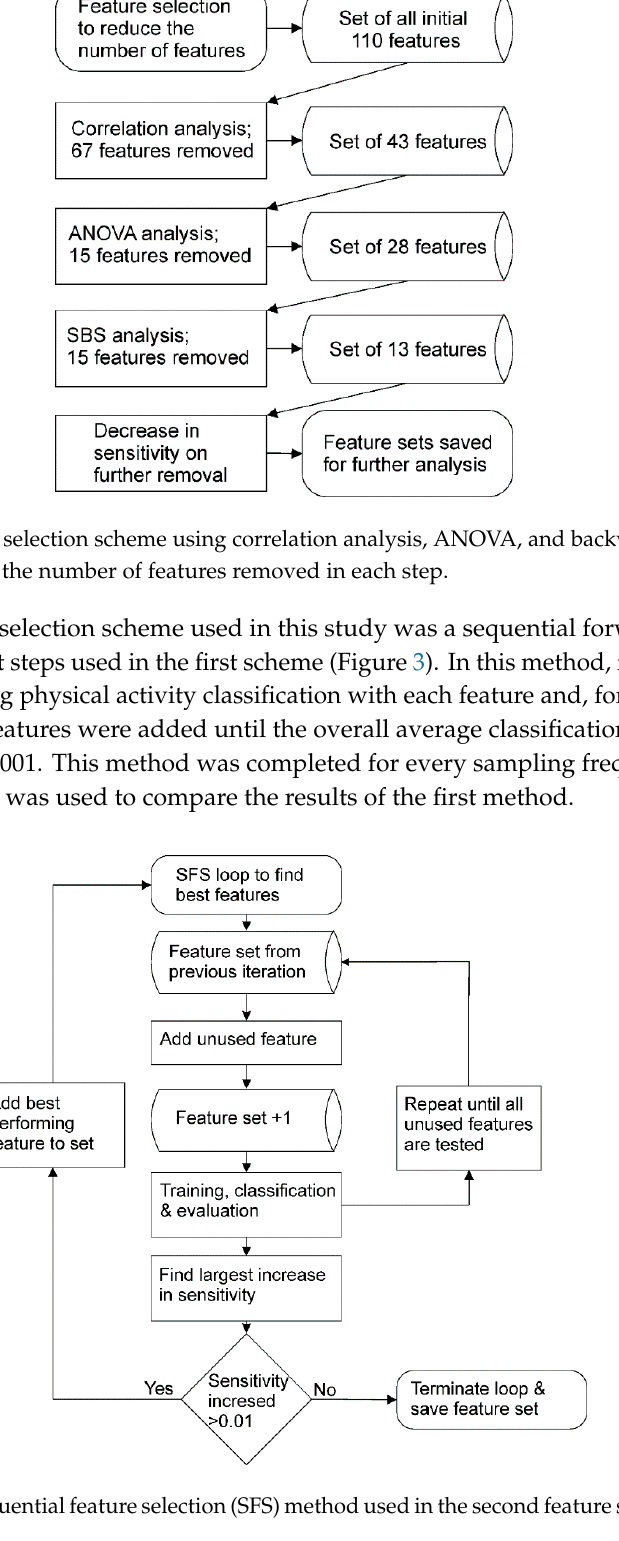
Figure 3. Forward sequential feature selection (SFS) method used in the second feature selection scheme.